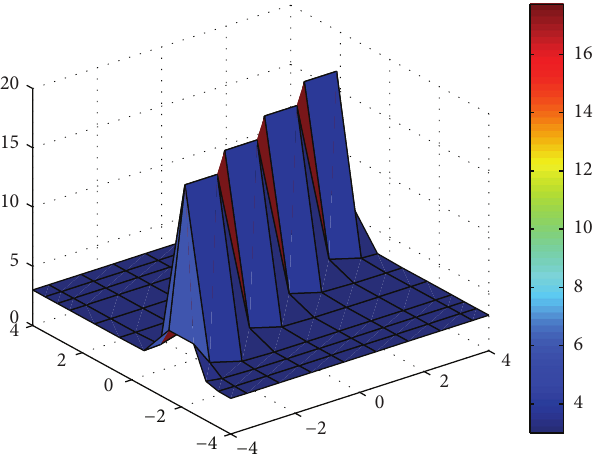
Figure 9: The solitary wave and behavior of the solutions ℎ(𝑥,𝑦, 𝑡) = 1 + tanh 2 (𝑥 − 2𝑦 + 𝑡)/(1 + sech (𝑥 − 2𝑦 + 𝑡)) 2 + (1 + sech (𝑥 − 2𝑦 + 𝑡)) 2 / tanh 2 (𝑥 − 2𝑦 + 𝑡) for 𝑡 = 0 , −4 ⩽ 𝑥 ⩽ 4 , and −4 ⩽ 𝑦 ⩽ 4